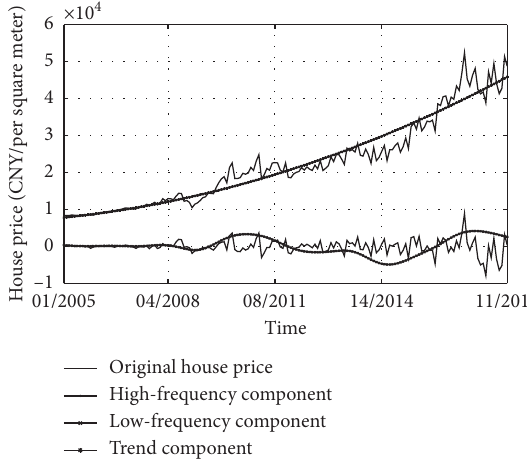
Figure 4: Original house prices and three corresponding composed components.